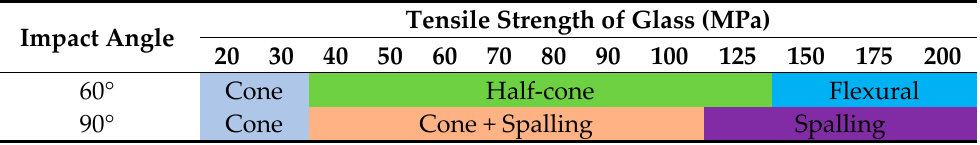
Table 8. Impact failure modes at v = 5 m/s with different fracture energies of glass. Impact